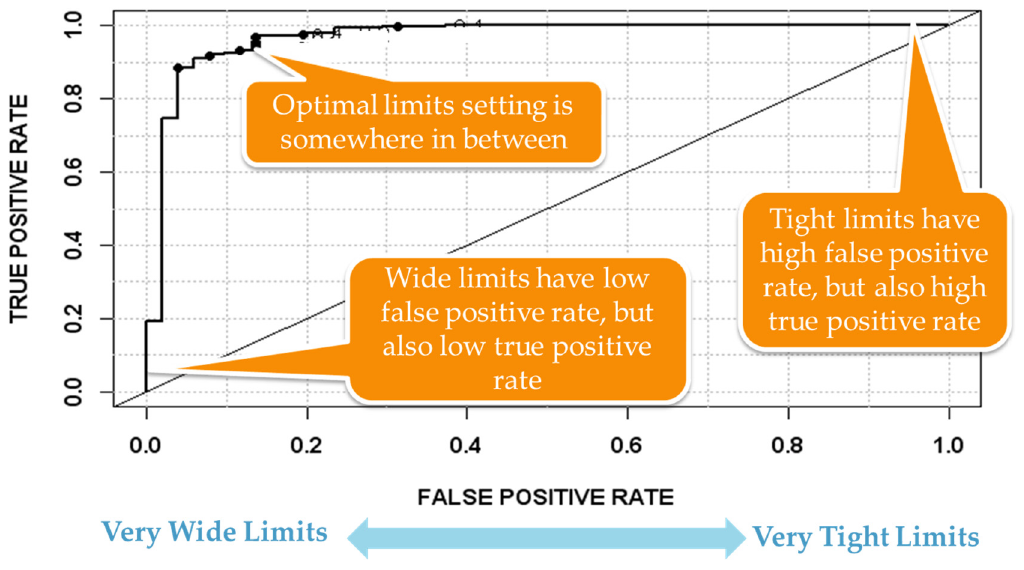
Figure 7. Usage of receive operating characteristic (ROC) plots to determine optimal fault detection (FD) limits settings; plot of true/false positive rates as a function of FD limits settings.